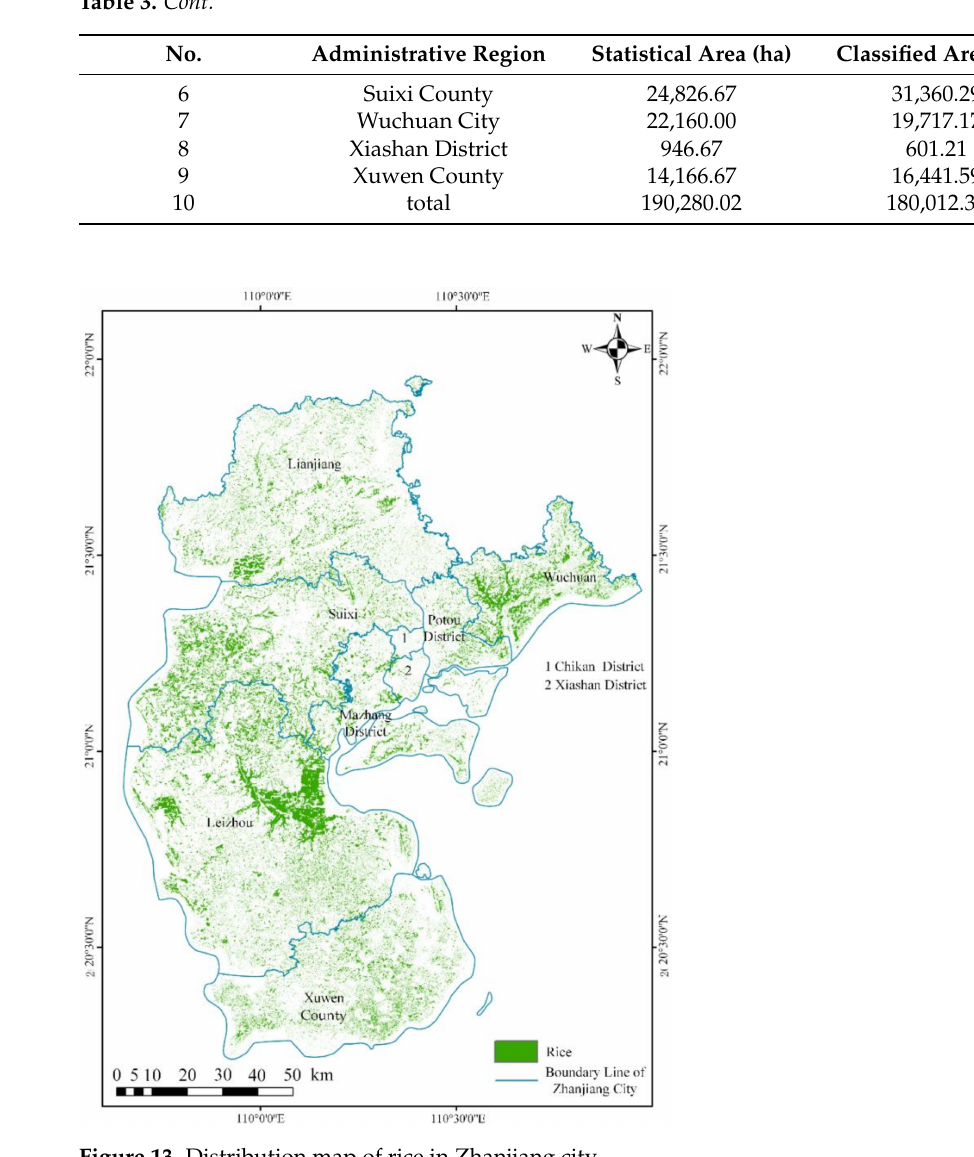
Figure 13. Distribution map of rice in Zhanjiang